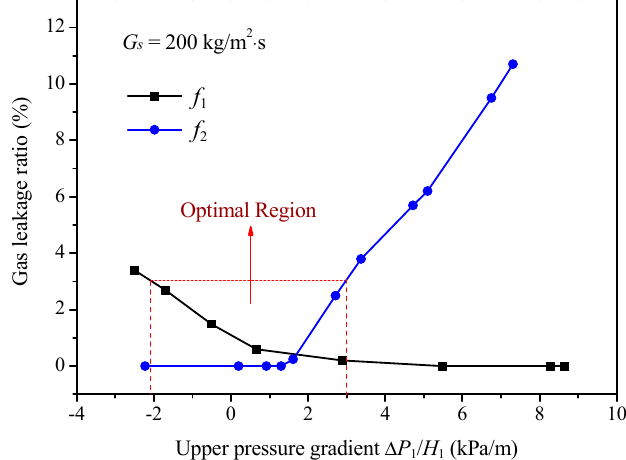
Figure 8. Variations of FR leakage ratio and AR leakage ratio with the upper pressure gradient.